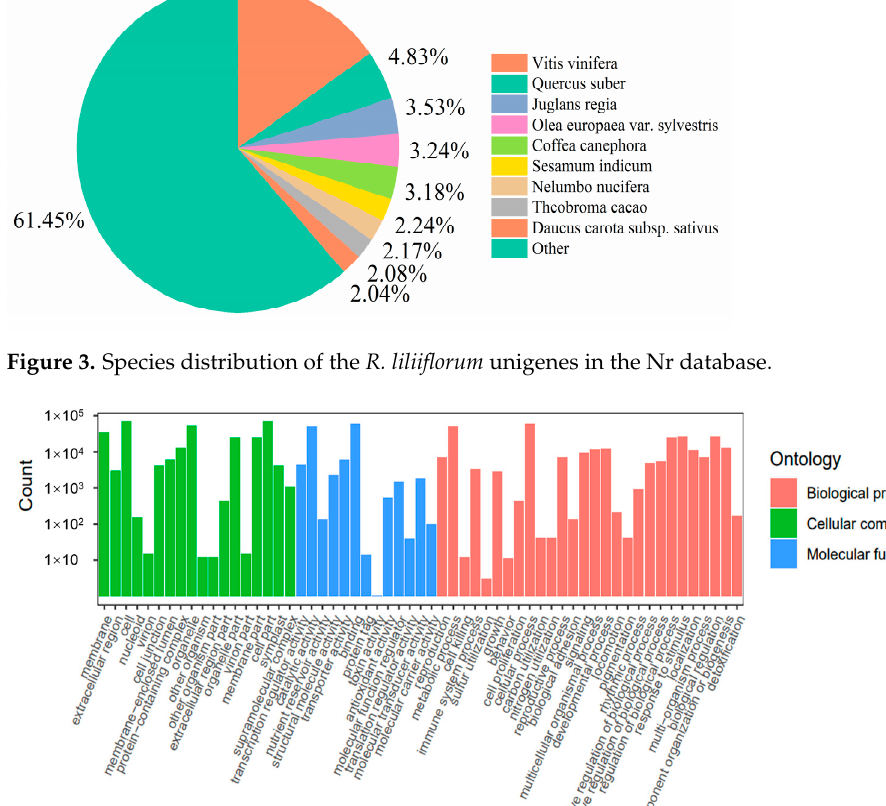
Figure 3. Species distribution of the R. liliiflorum unigenes in the Nr database.